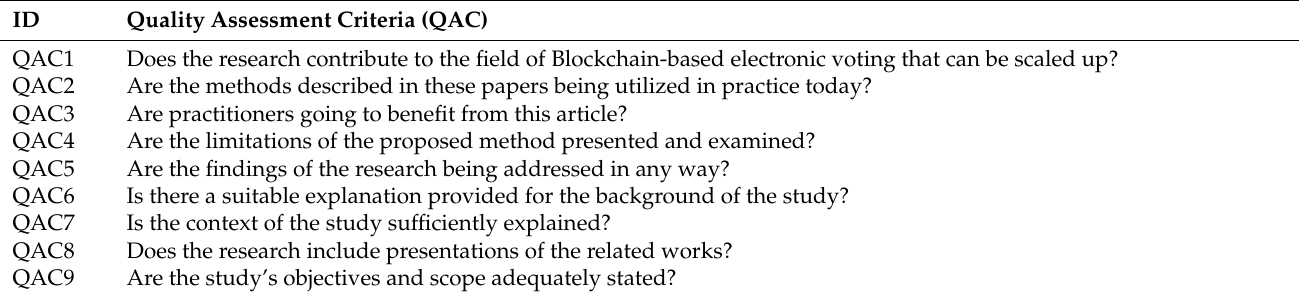
Table 7. Quality